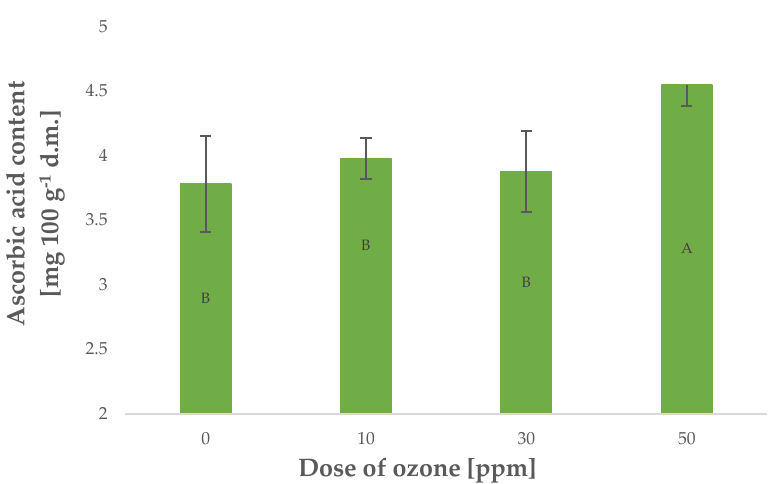
Figure 3. Ascorbic acid content in barley young plants depending on the dose of ozone ( n = 20): differences between the results for the dose of ozone treatment are marked with capital letters; significance level is defined as p < 0.05.